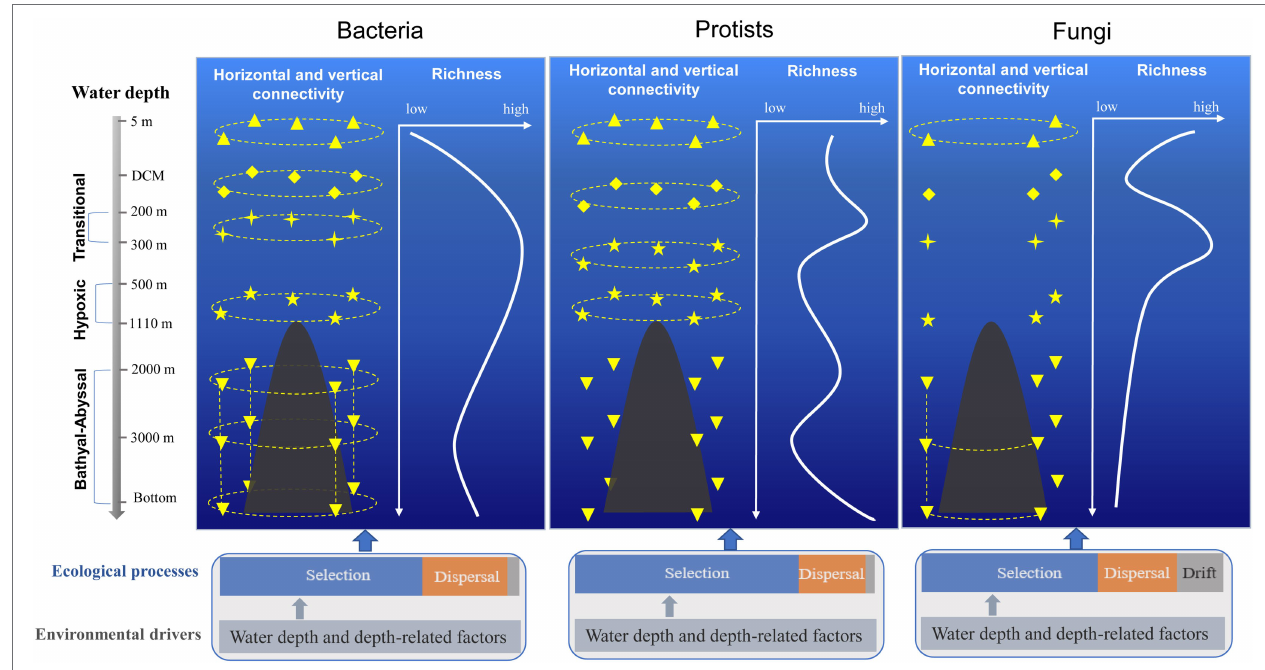
FIGURE 5 | Conceptual model of the seamount effect on diversity, distribution, and connectivity patterns of bacterial, protist, and fungal